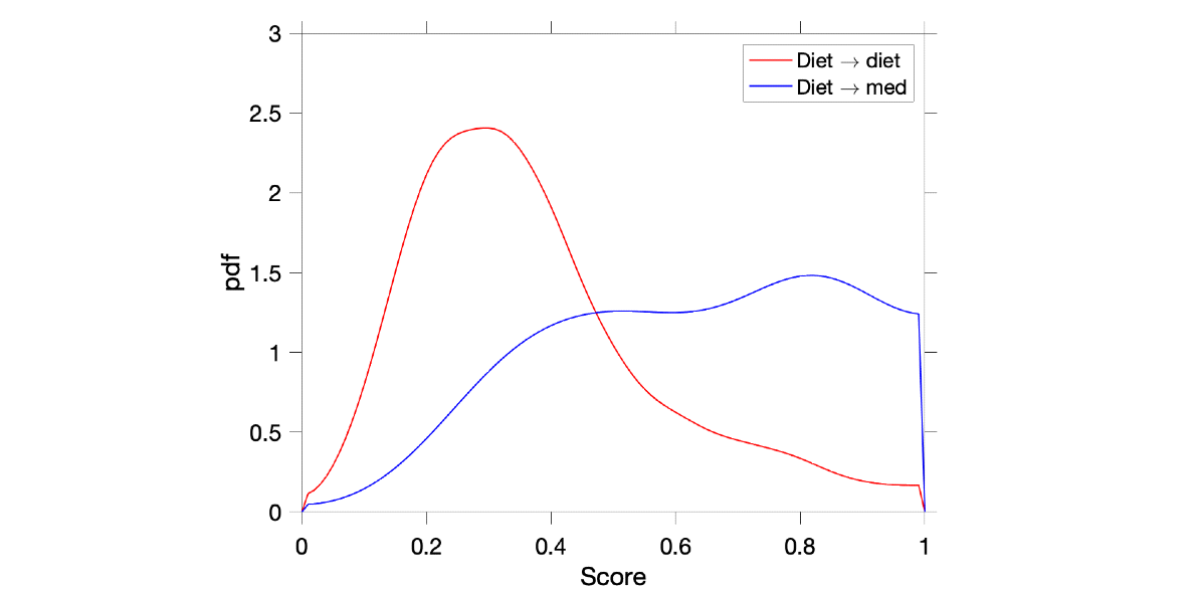
Figure 7. Distribution of scores from a model close to median performance (area under the curve 0.80). The model uses 4 features to perform its function. Although scores for the diet–diet group are clearly distributed on the left-hand side of the graph, the diet–med group presents higher